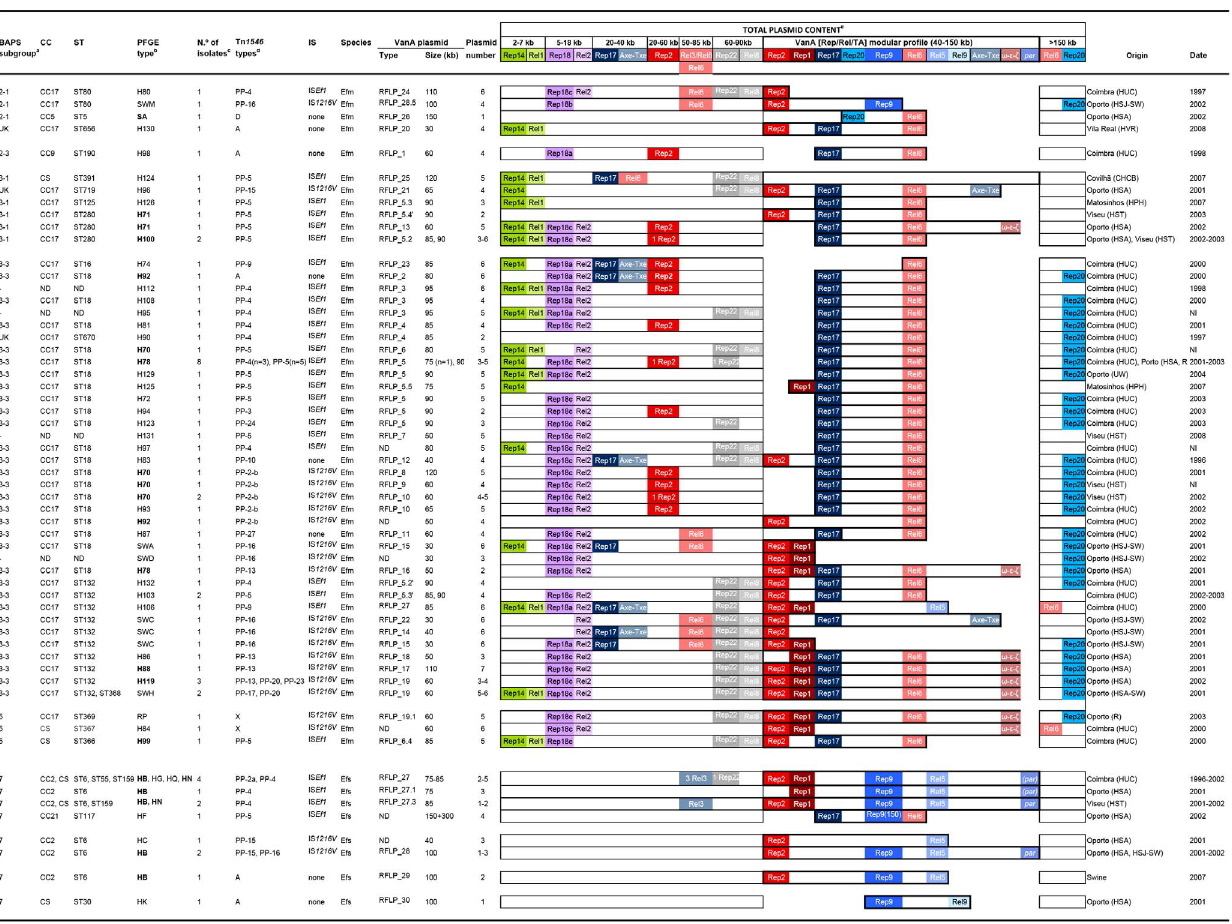
Figure 2. Clonal and plasmid diversity among VREfm and VREFs from Portugal. Abbreviations: IS, insertion sequence; Efm, Enterococcus faecium ; Efs, Enterococcus faecalis ; kb, kilobases; BAPS, Bayesian Analysis of Population Structure; ST, sequence type; CC, clonal complex; rep (replicases); rel (relaxases); TA (toxin-antitoxin system); HUC, Hospital Universita´rio de Coimbra; HSA, Hospital Santo Anto´nio; HSJ, Hospital Sa˜o Joa˜o; HST, Hospital Sa˜o Teoto´nio; HPH, Hospital Pedro Hispano; CHCB, Centro Hospitalar da Cova da Beira; HVR, Hospital S. Pedro; SW, sewage wastewaters; UW, urban wastewaters; R, river; ND, not determined; NI, not identified; UK, unknown. a The distribution of the different isolates is shown by BAPS subgroups as described [19]. b PFGE types shown in bold represented widespread clones in Portuguese hospitals and/or aquatic surroundings over years. c Most Efm isolates expressed resistance to vancomycin, teicoplanin, erythromycin, ampicillin, ciprofloxacin (92–100%) and to a lesser extent to high levels of kanamycin (65%), gentamicin (41%), streptomycin and tetracycline (28% each). While acm was identified in different CC17 and non- CC17 lineages (76%), esp was detected in CC17 isolates (35%, ST132 and its SLVs ST368, ST369) and hyl was sporadically found (9%, ST18, ST125, ST132, SLVs of each other, and ST280 isolates) [25]. Efs isolates (mostly ST6) showed resistance to vancomycin, teicoplanin, erythromycin, ciprofloxacin, high levels of gentamicin and kanamycin (82–100%), tetracycline and chloramphenicol (65% each) and high levels of streptomycin (46%), and mostly contained gelE and agg ( . 90%), cyl (82%) and esp (46%) [26]. d Tn 1546 designation is based on the results obtained by a PCR assay described by Woodford et al. consisting on the amplification of overlapped fragments covering the whole Tn 1546 [68]. Fragments of unexpected length were further analysed by sequencing (this study) [27]. e The total rep/rel/TA content of isolates is represented according to its location on plasmids of different size ranges. Rep (normal cells), rel (cells with dots) and TA (cells with diagonal stripes) genes belonging to the same plasmid are represented with the same color and that belonging to the same plasmid family with the same range of colors. The content of VanA plasmids including rep, rel, and TA genes is indicated according to the plasmid type in which they were identified, as well as by the numeric nomenclature used by Jensen et al . [72] for replicases (rep 1 , rep 2 , rep 9 , rep 14 , rep 17 , rep 18a ), given new and consistent designations to replicases non described in reference 72 (rep 18b , rep 18c , rep 20, rep 22 ). Relaxases were designated per numerical order as designed by M. V. Francia (unpublished data). Rolling- Circle plasmids are represented in green (rep 14/pRI1-like , rel 1/pRI1 ), small-theta replicating plasmids in violet (rep 18a/pEF418 , rep 18b/pB82 , rep 18c/pCIZ2 , rel 2/pCIZ2 ), Inc18-like plasmids in different red tones (rep 1/pIP501 , rep 2/pRE25/pEF1 , rel 6/pEF1 , TA Inc18- v - e - f ), RepA_N plasmids in different blue tones, pRUM in dark blue (rep 17/pRUM , rel 3/pRUM , TA pRUM-Axe-Txe ), pLG1 in turquoise (rep 20/pLG1 ), pheromone-responsive plasmids in light blue (rep 9/pAD1 , rel 5/pAD1 , rel 9/pCF10 , par pAD1 ), and pHT b /pMG1 plasmids in grey (rep 22/pHT b , rel 8//pHT b ). Rep families are named Rep ˝n˝ where˝n˝ indicates the number assigned to different rep-families according to Jensen et al . [72]. The name of the most representative plasmid of the family is also represented for a better follow- up of the results (e.g. rep 17/pRUM , rep17 from pRUM and related plasmids p5753cB and pS177; rep 1/pIP501 rep1 linked to Inc18 plasmids as pIP501, pIP816 and pRE25; rep 9/pAD1 , rep9 linked to pCF10, pAD1, pTEF1, pTEF2, pBEE99, pMG2200; rep 14/pRI1-like , rep14 associated with RCR plasmids pEFNP1, pJS42 and/or pRI1; rep 18a/pEF418 , rep18 from pEF418; and rep 22/pHT b , rep of both pHT b and pMG1 plasmids). We further specified the name of different plasmids associated with a given group if necessary. For example, it results helpful for Inc18 family given the number of plasmids containing the same rep gene. These plasmids are increasingly identified among isolates of different origins (e.g. rep 2/pRE25/pEF1 for designing rep2, as rep and rel modules of pEF1, a plasmid originally identified in olives [35], seems to be widely present in all Efm clinical isolates) . Sequencing identified the different variants within these families (see text). Rep 18b , rep 18c and rep 20 were not included in Jensen’s scheme [72] and the numbers were assigned in this paper following that numeration (rep 18b/pB82 , rep from pB82; rep 18c/pCIZ2 , rep from pCIZ2; rep 20/pLG1 , rep from pLG1). Rel genes were arbitrarily